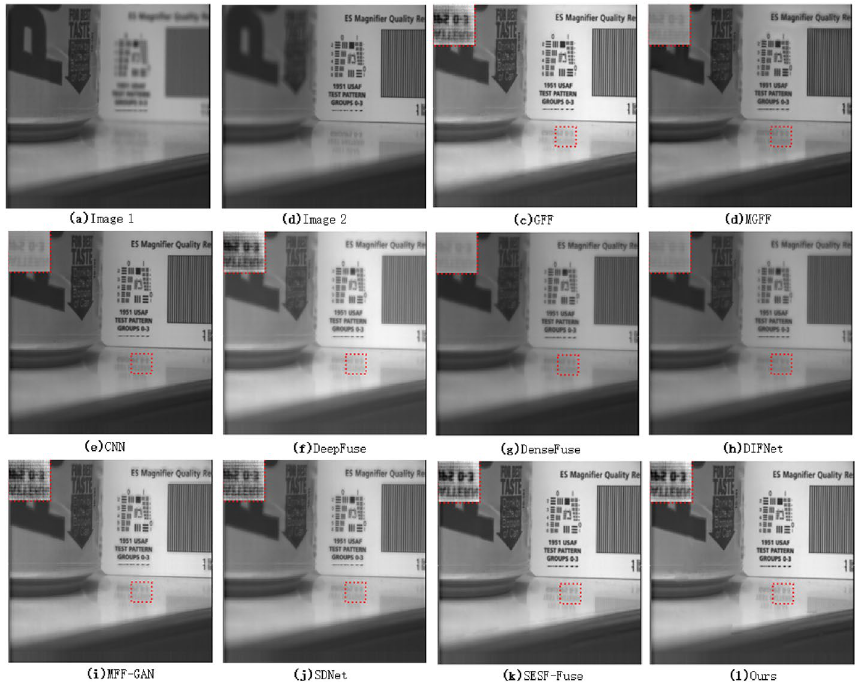
Figure 4. Image local comparison 2(Savic pepsi 36 ).